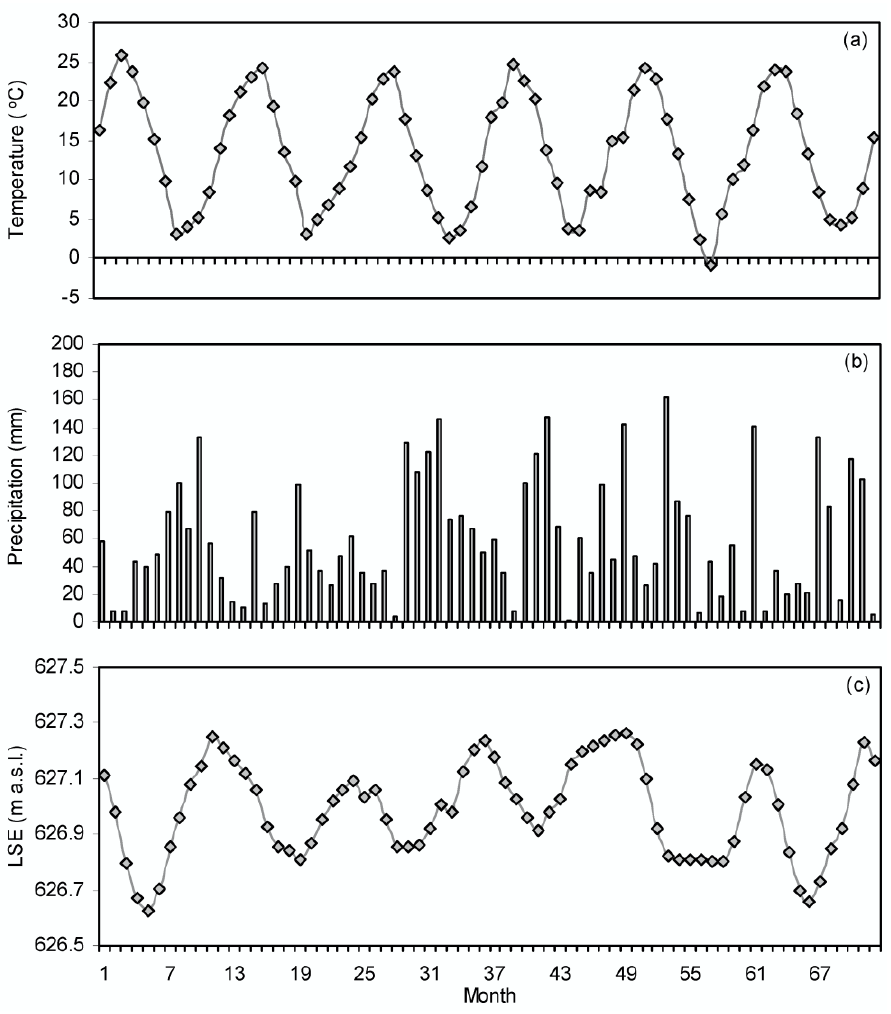
Figure 2. ( a ) Mean temperature, ( b ) precipitation and ( c ) lake surface elevation ( LSE ) in m above sea level (a.s.l.) for each month for the period May 2012 to April 2018 (72-months period). Additional GIS datasets and databases used for this study include: